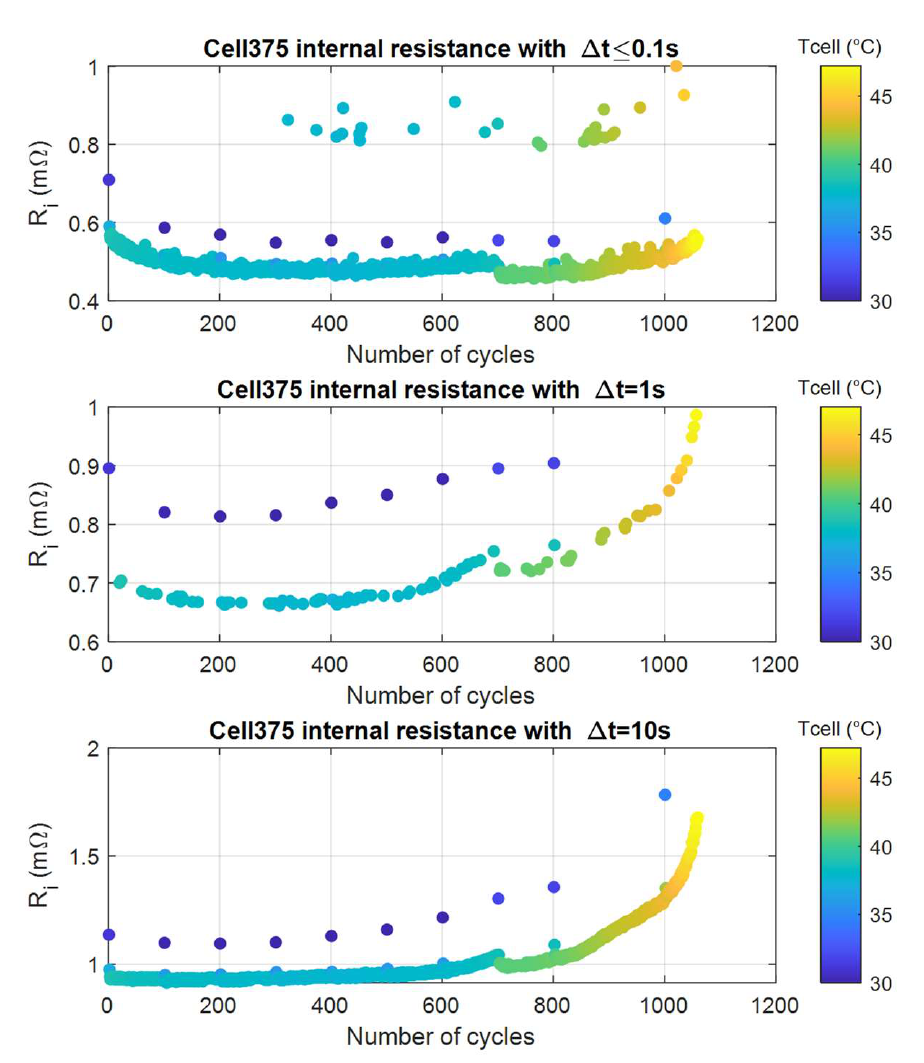
Figure 8. Trend of the start-of-discharge internal resistance for cell375 at SOC = 50% as a function of the number of cycles and cell case temperature for different ∆ t intervals.